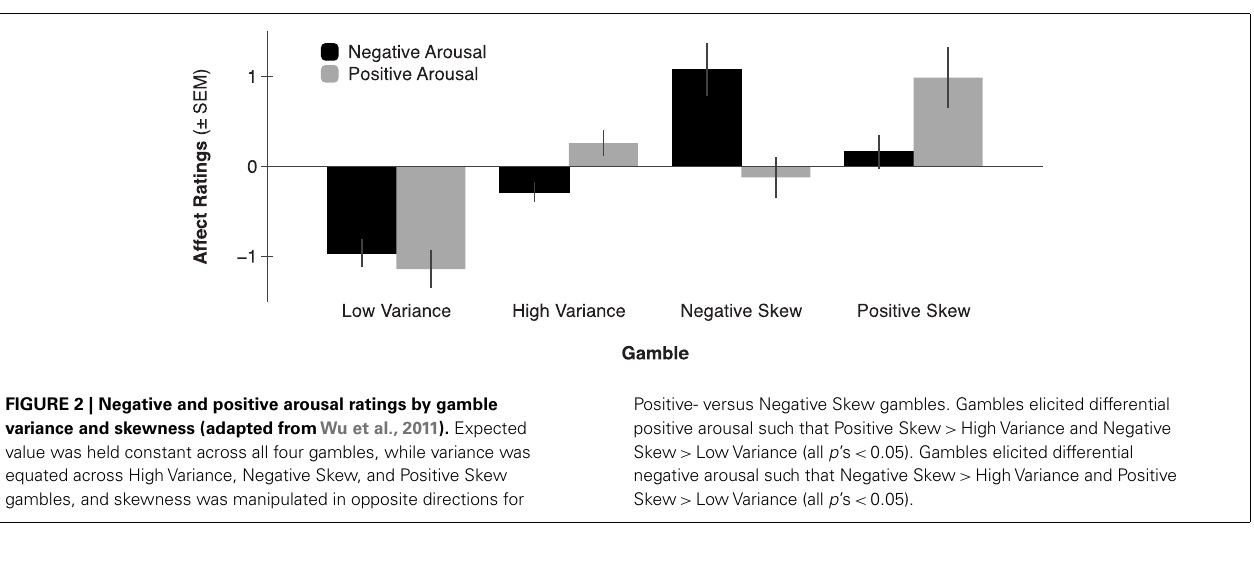
Positive- versus Negative Skew gambles. Gambles elicited differential positive arousal such that Positive Skew > HighVariance and Negative Skew > LowVariance (all p ’s < 0.05). Gambles elicited differential negative arousal such that Negative Skew > HighVariance and Positive Skew > LowVariance (all p ’s <